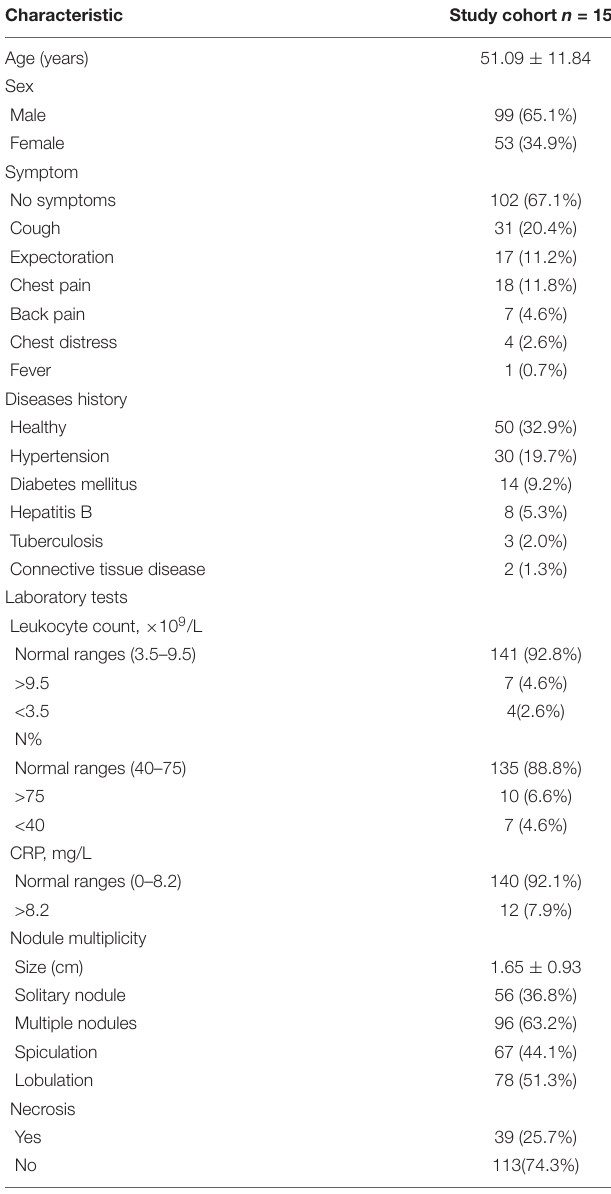
TABLE 1 | Demographic and clinical characteristics of 152 patients with pulmonary